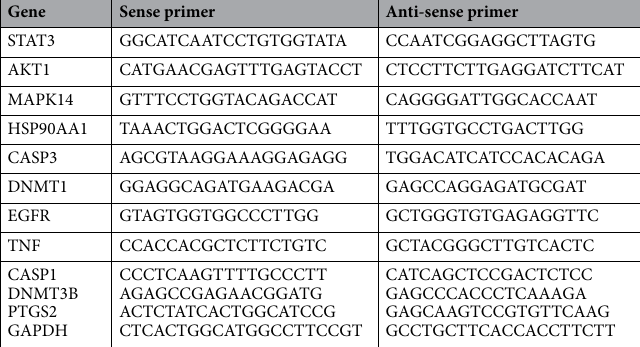
Table 1. Real-time polymerase chain reaction